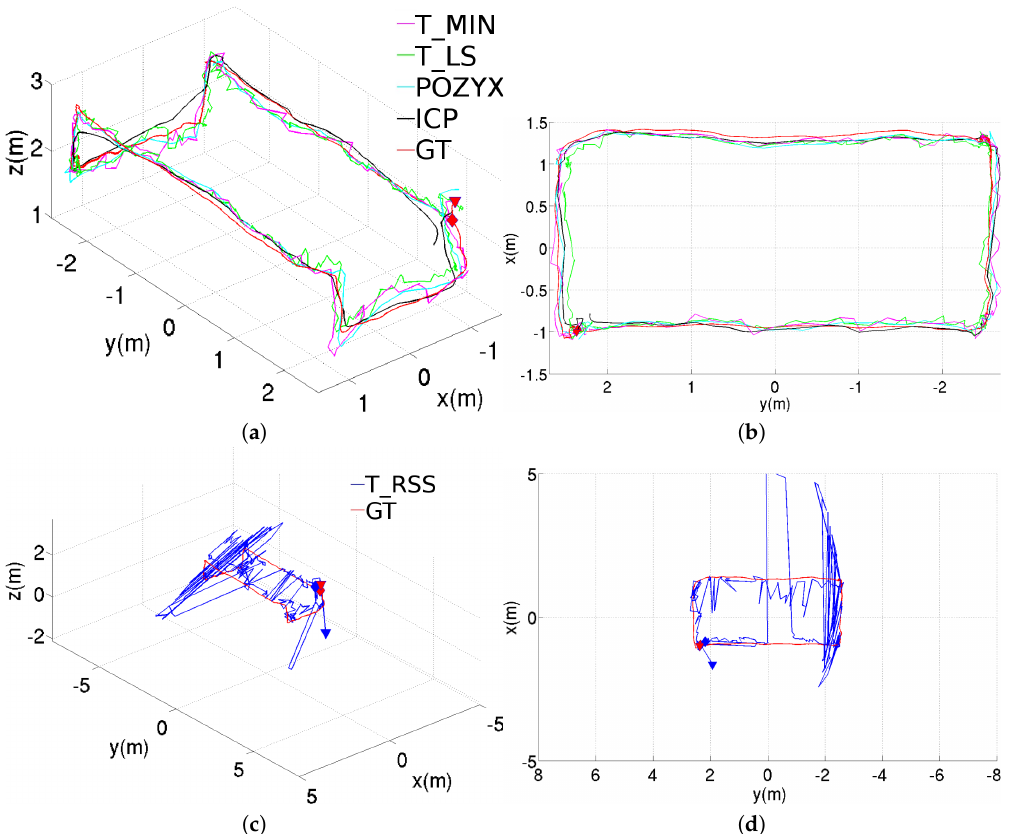
Figure 7. Position estimations provided by the different methods for the rectangular trajectory with changes in height using the standalone configuration, results for the T_RSS method are shown separately to facilitate the comparison: ( a ) perspective and ( b ) top views for T_MIN, T_LS, POZYX and ICP, ( c ) perspective and ( d ) top views for